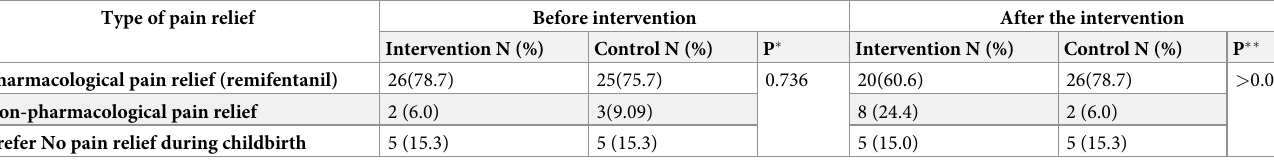
Table 2. The frequency of selected pain relief in the intervention and control groups.